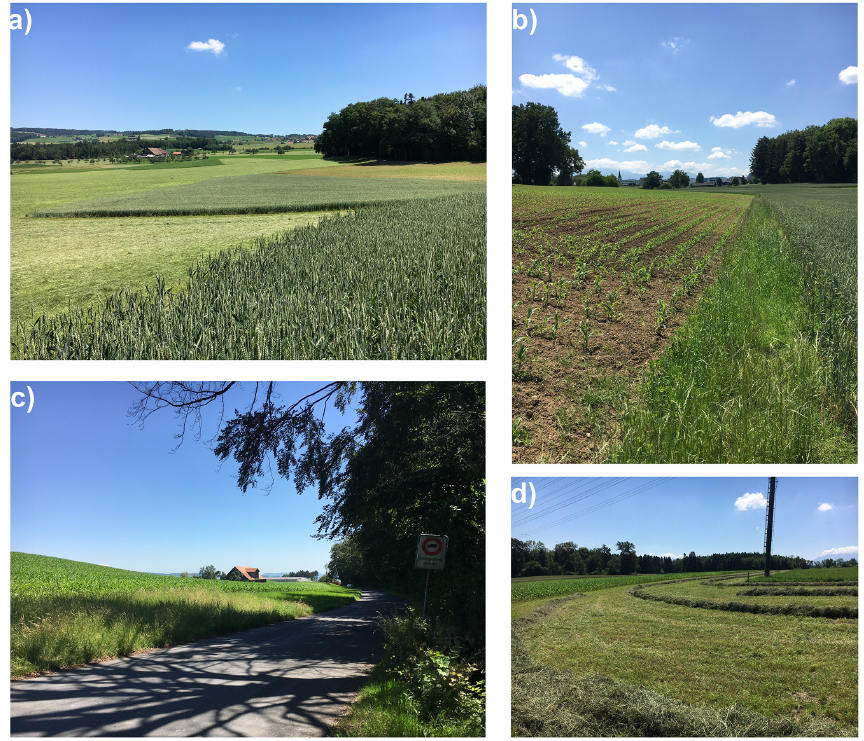
Figure 2. Typical agricultural landscapes from the Baldegg catchment. (a) Small arable and grassland patches within larger field blocks. (b) Grass buffer strip between maize and wheat fields. (c) Wide grass buffer strip between maize field and a vicinal road. (d) Freshly cut hay from a pasture between maize